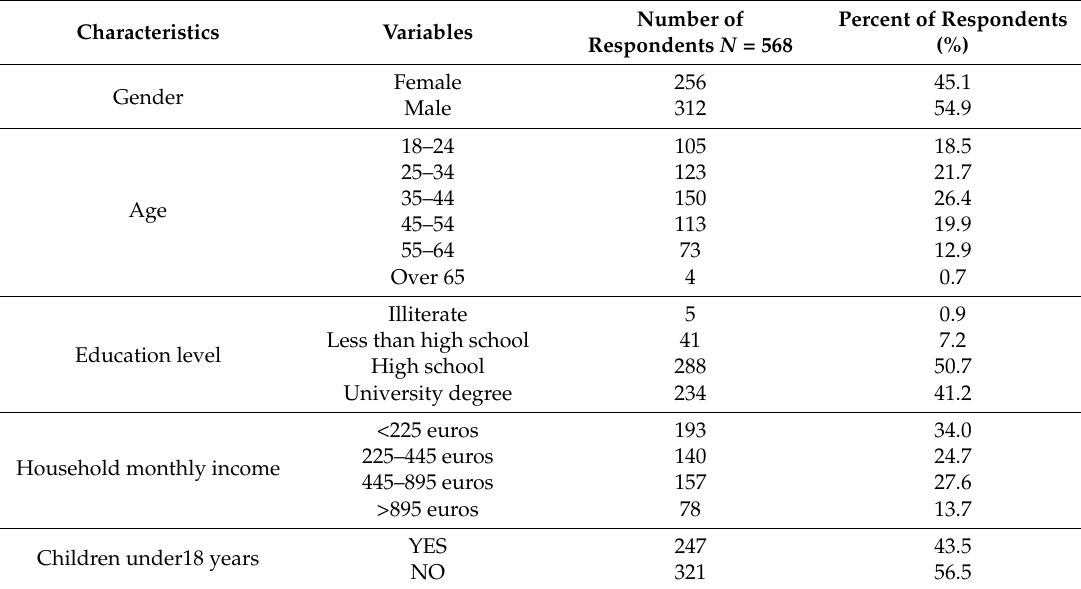
Table 2. Socio-demographic